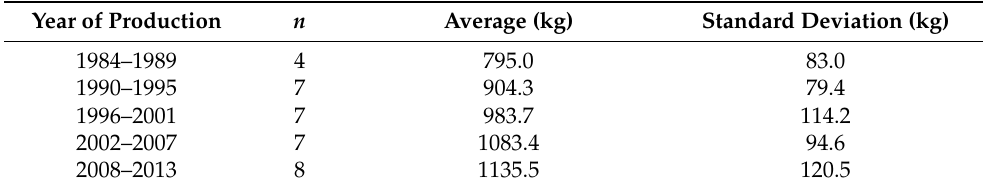
Table 2. Average weight of passenger cars.